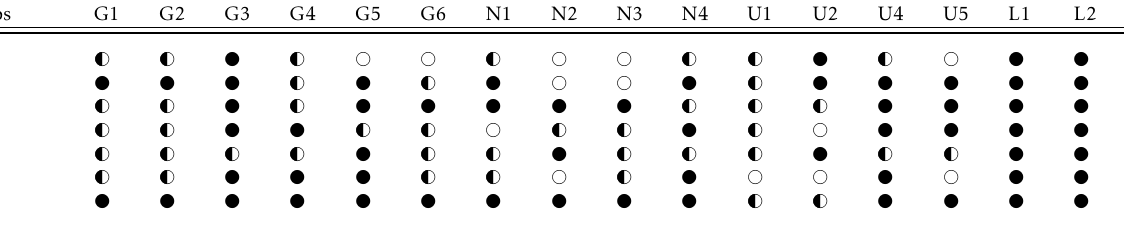
Table 3. Implementation of accessibility guidelines in the current